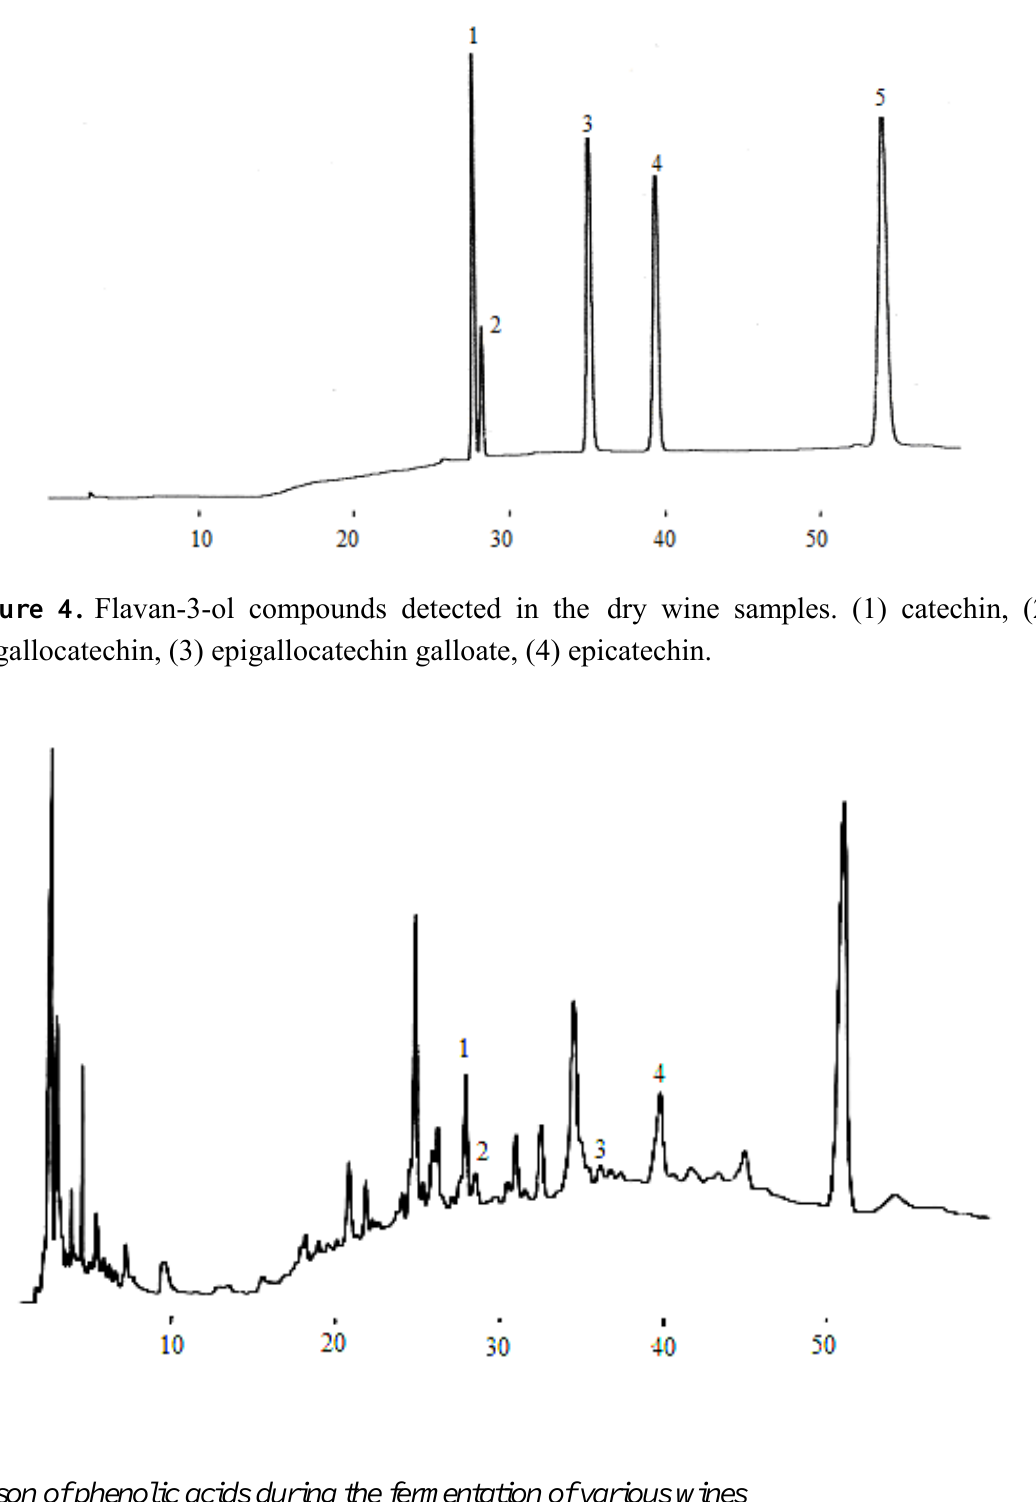
Figure 3. Chromatogram of five flavan-3-ol standards. (1) catechin, (2) epigallocatechin, (3) epigallocatechin galloate, (4) epicatechin, (5) epicatechin galloate.